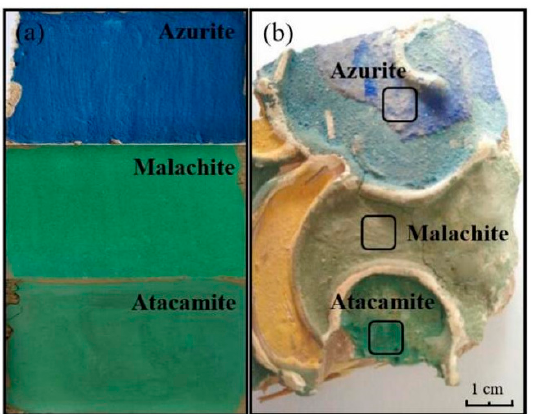
Figure 1. ( a ) Mock-up mural samples in the laboratory, ( b ) actual mural fragment from the Mogao Grottoes.